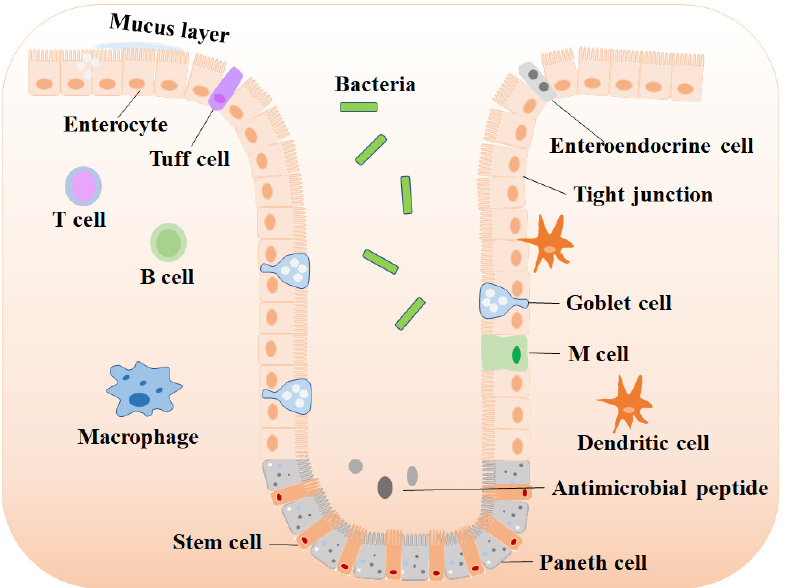
Figure 1. The structure of the intestinal mucosal barrier. The intestinal mucosal barrier consists of the epithelium layer, the mucus layer and immune cells. The intestinal epithelial cells include stem that locate at base invaginations and the differentiated cells (absorptive enterocytes, goblet cells, Paneth cells, tuff cells and enteroendocrine cells). Immune cells reside underneath the epithelium, which include dendritic cells, M cells, macrophages, B cells and T cells.